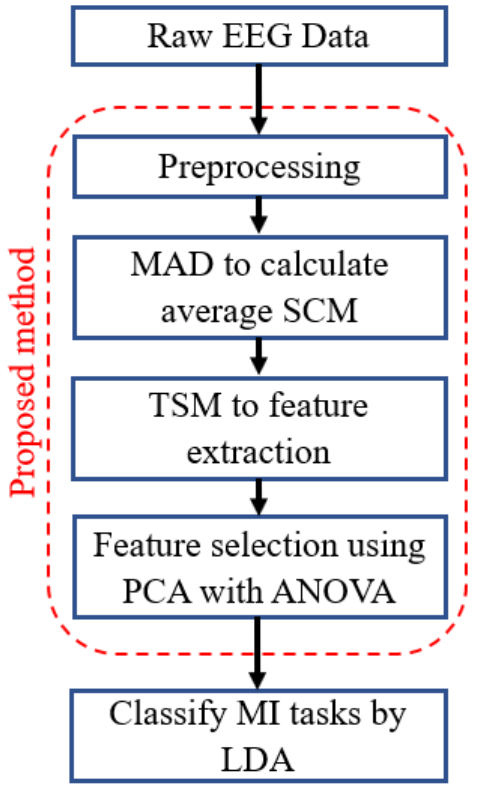
Figure 1. The basic block diagram of a motor imagery (MI) classification